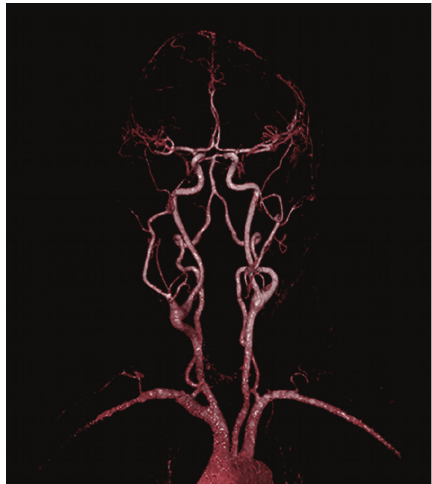
Figure 2: MRA of the neck demonstrating splaying of the internal and external carotid arteries, that is, the “lyre